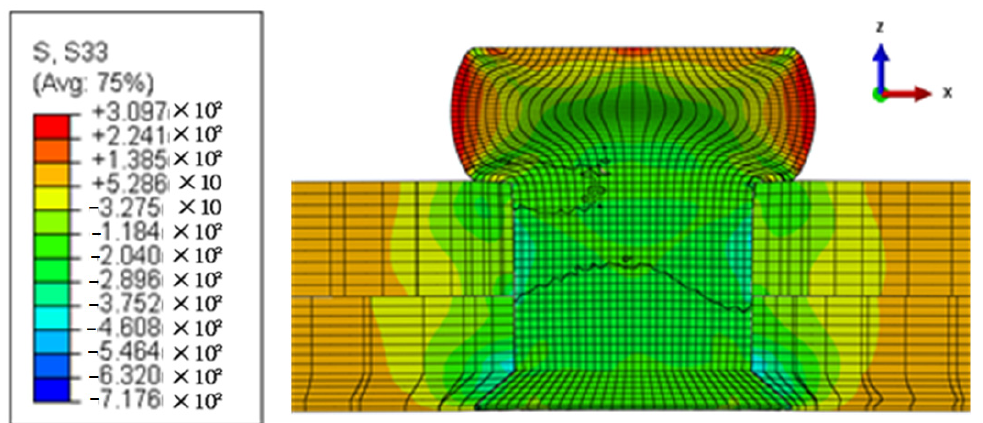
Figure 6. Residual circumferential stress around rivet and hole (unit: MPa).